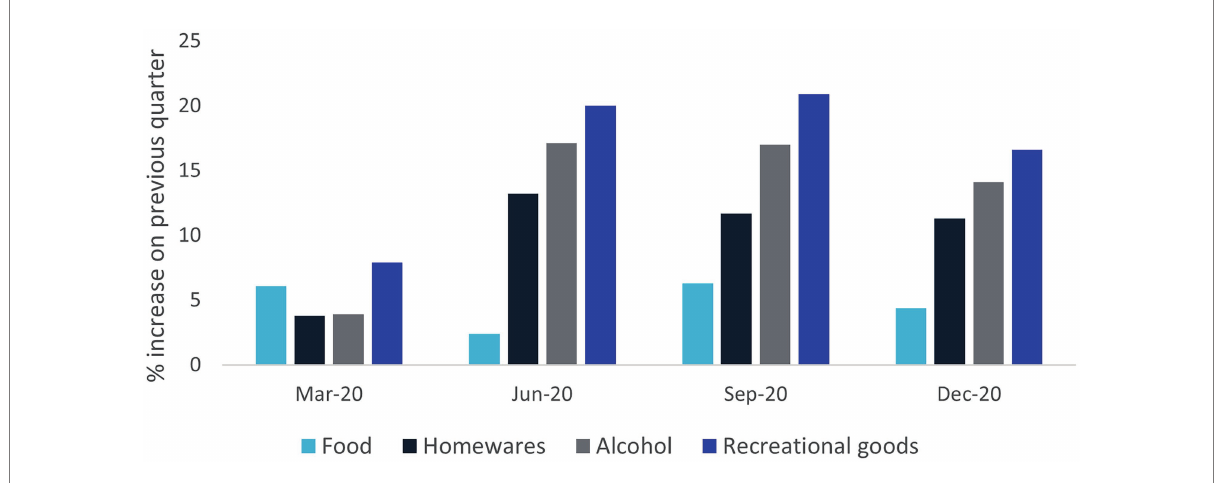
FIGURE 1 Growth in household spending on goods, by category, Australia 2020. Source: Australian Bureau of Statistics, Insights into household consumption, December quarter 2020